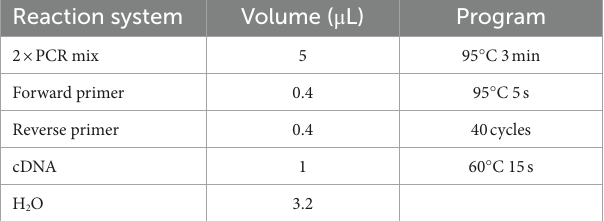
TABLE 2 Real-time quantitative PCR reaction system and